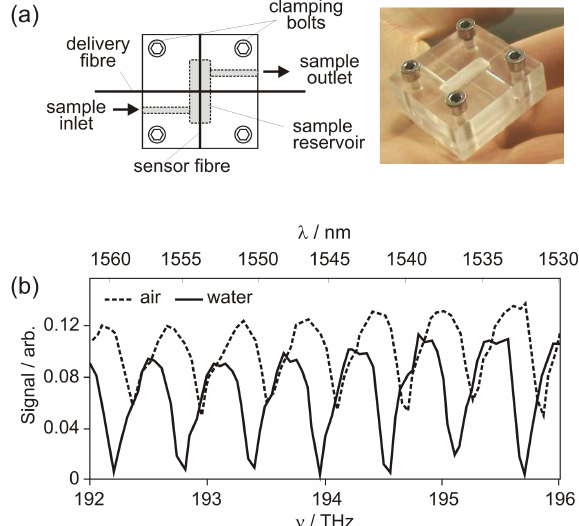
Figure 6. (a) Sample cell used for measurements in a liquid environment; (b) WGM spectra of a 125 µ m fibre measured in air and